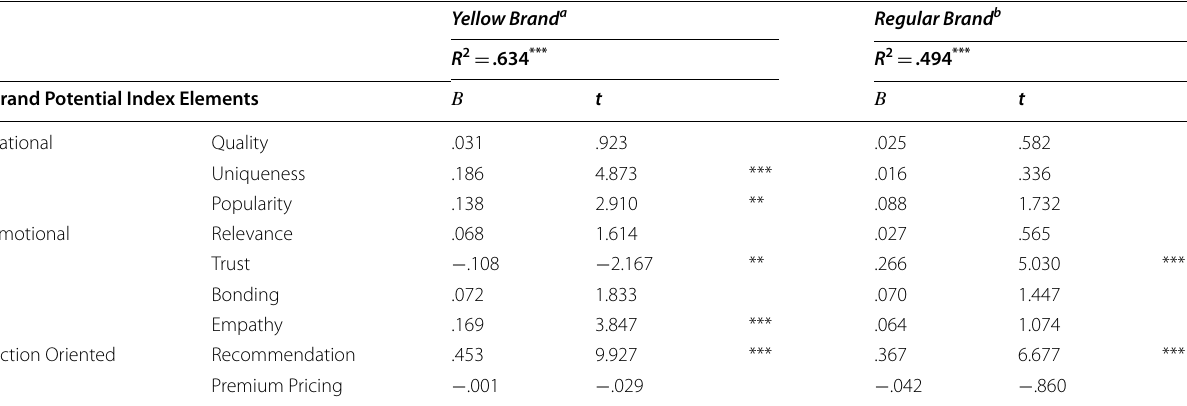
Table 1 Yellow and Regular Brand BPI Attributes Regressed on Purchase Intention